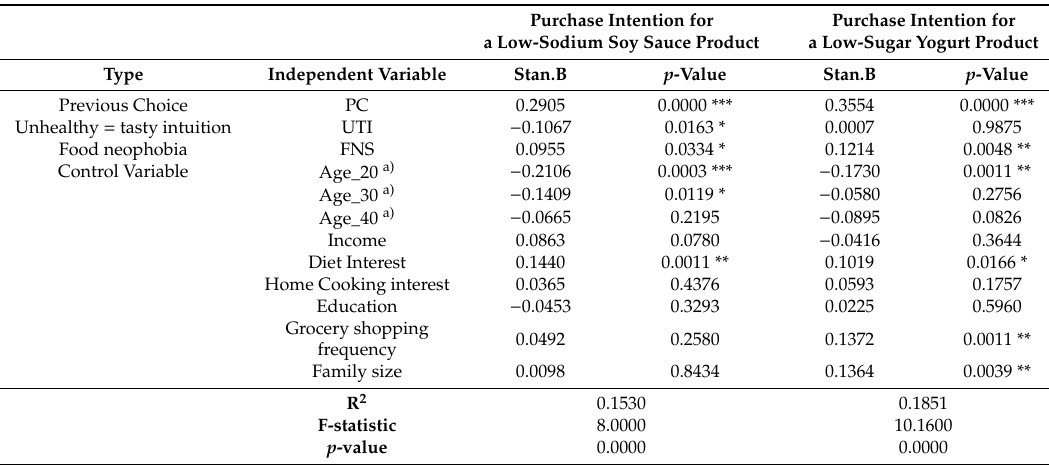
Table 8. Multiple regression analysis